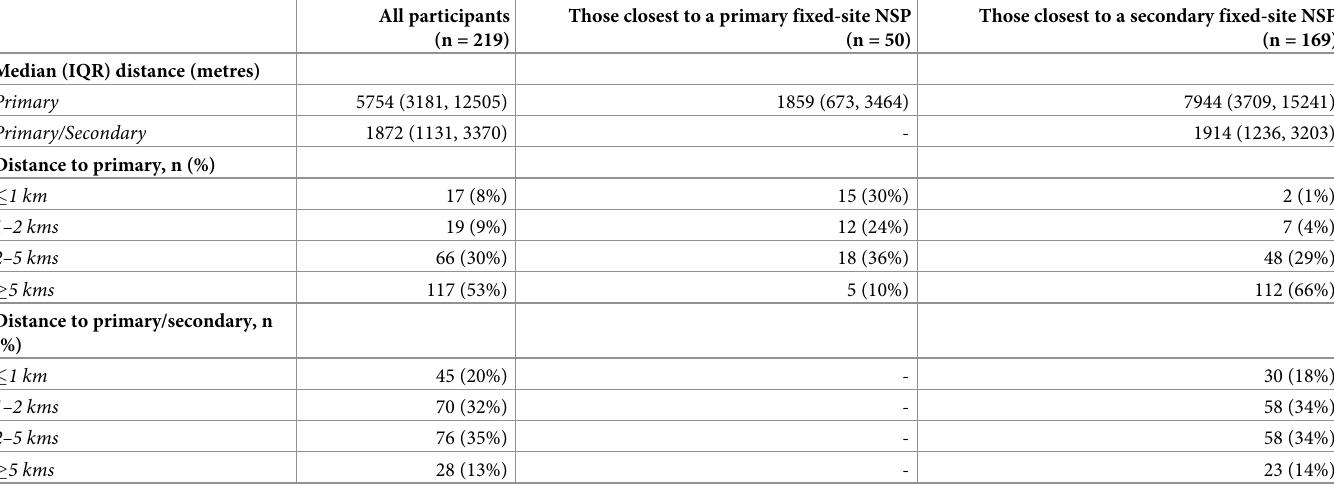
Table 2. Distance between participant residence and nearest NSP service type in Melbourne, Australia (2015–2016), stratified by participant’s nearest service